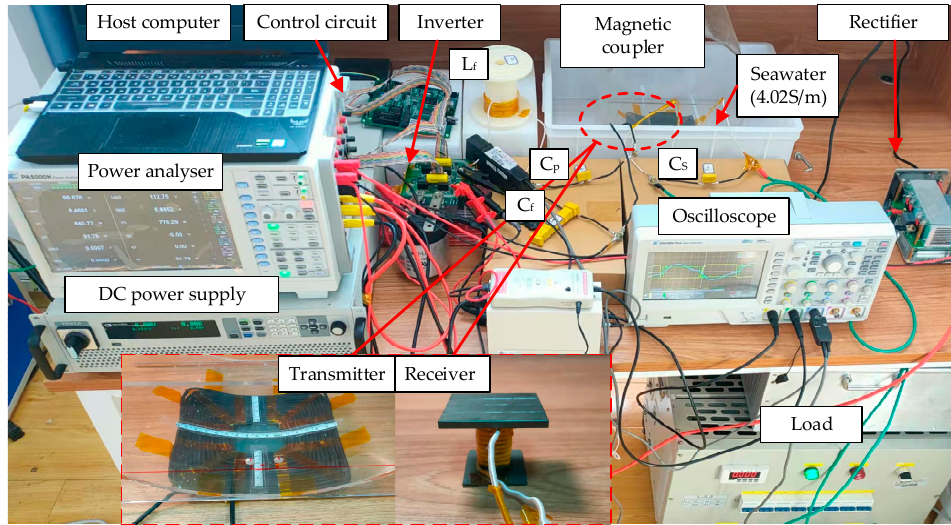
Figure 8. Experimental prototype.